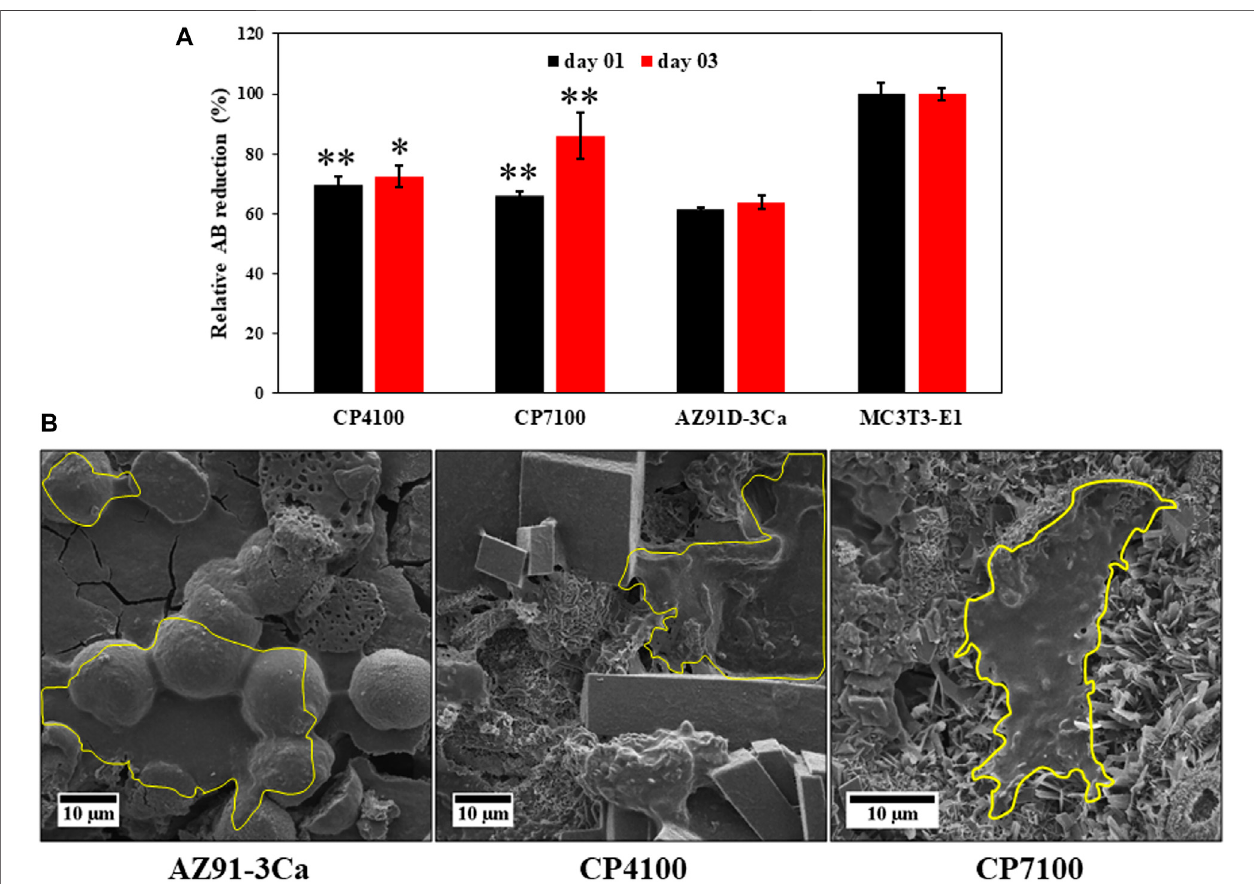
FIGURE 9 | (A) metabolic activity of MC3T3-E1 pre-osteoblast cell measured by Alamar blue assay at day 1 and 3 for coated and uncoated Mg alloy and MC3T3- E1cellsand (B) SEMmicrographofMC3T3-E1 cellattachment on coated anduncoatedsamplesurface fi xedusing 4%paraformaldehyde after 3 days ofculturing.Cell attachment region is highlighted in yellow